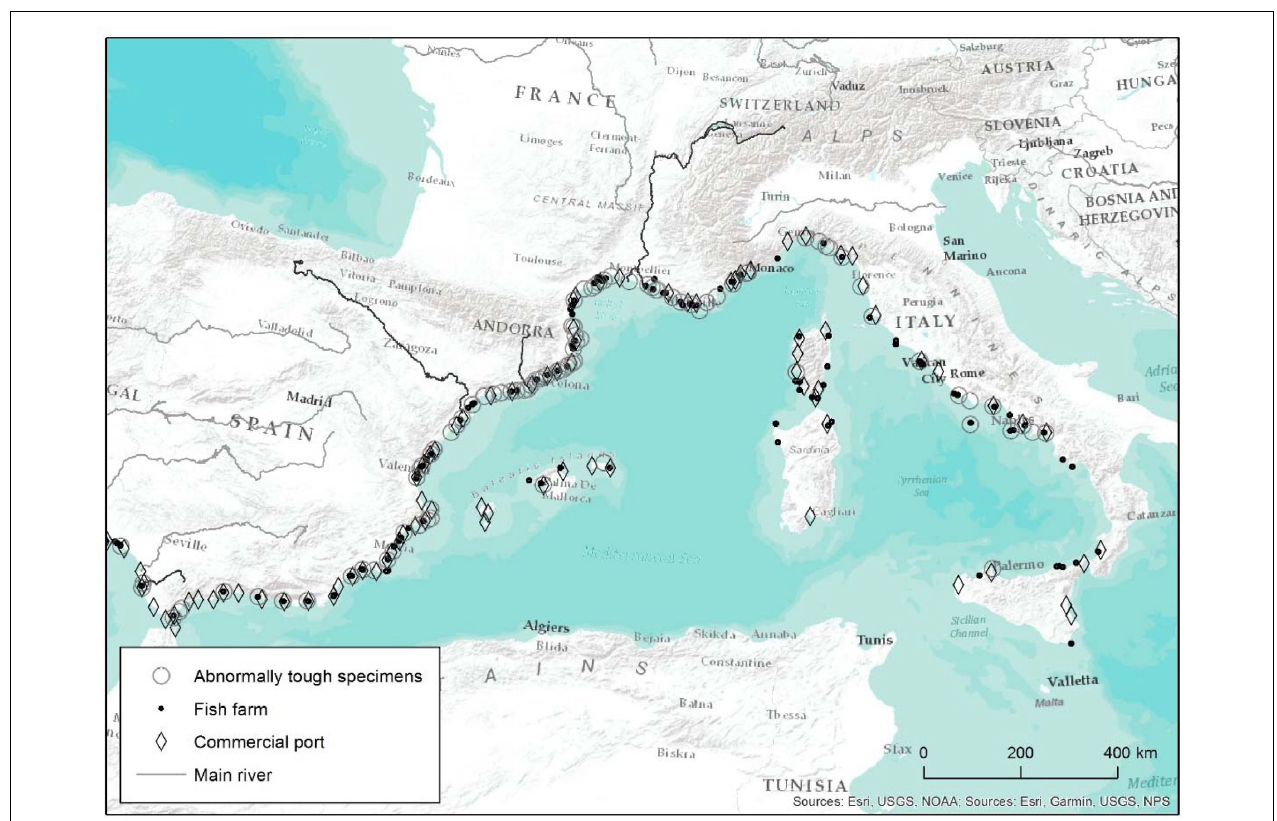
FIGURE 1 | Mediterranean locations where abnormally tough specimens of white seabream were captured according to survey data. The map includes the major port infrastructures and marine farms. The only four rivers mentioned in survey reports are also highlighted (Rhône, Llobregat, Ebre, and